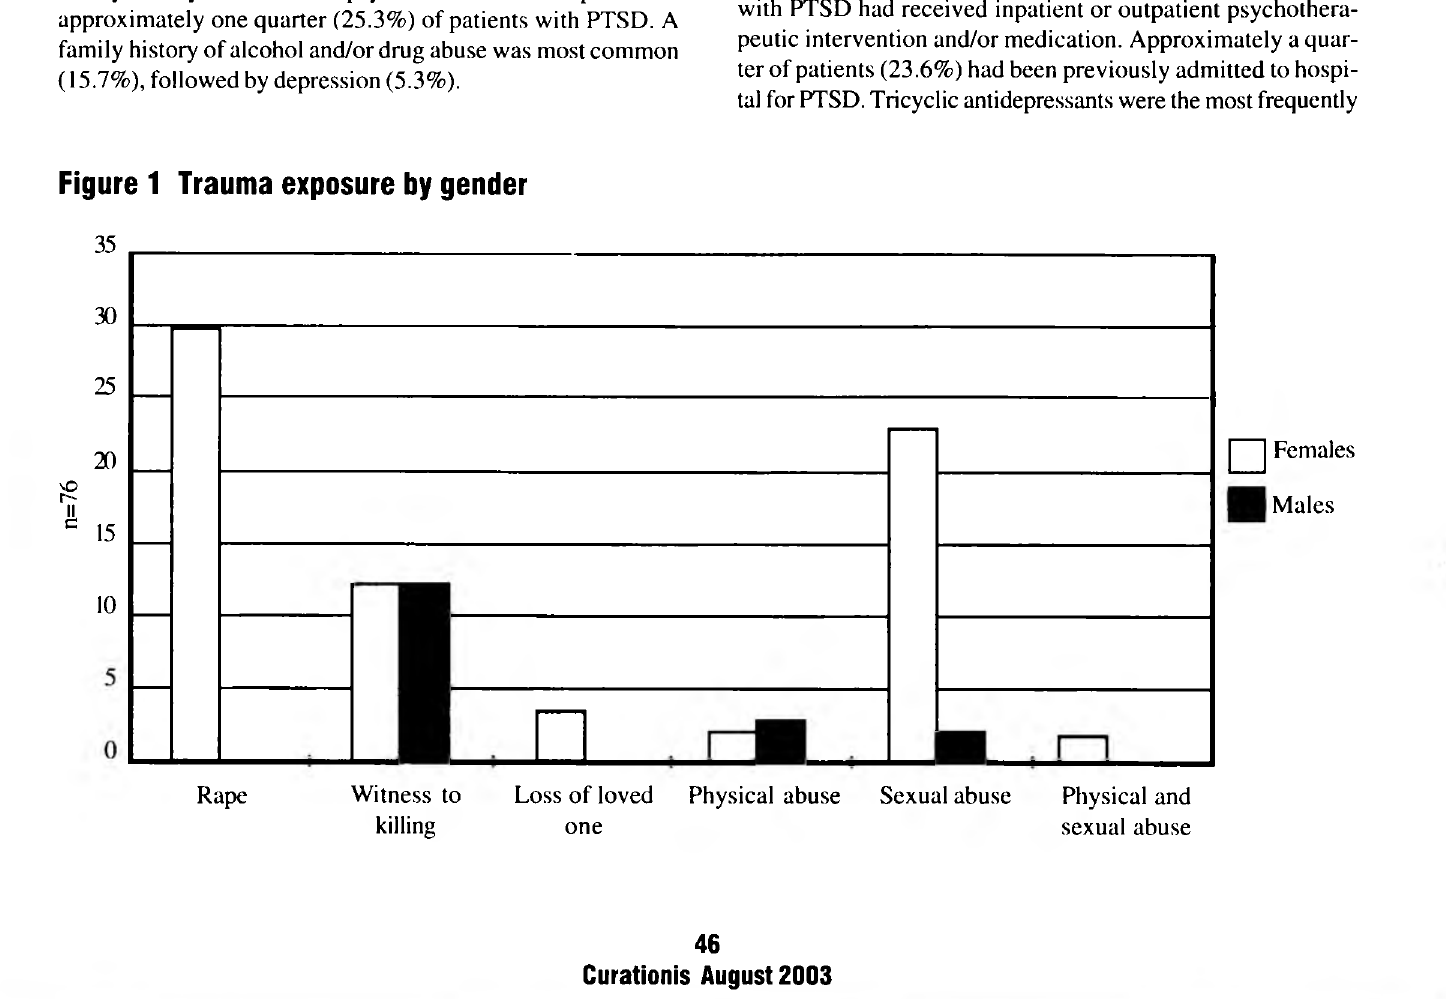
Figure 1 Trauma exposure by